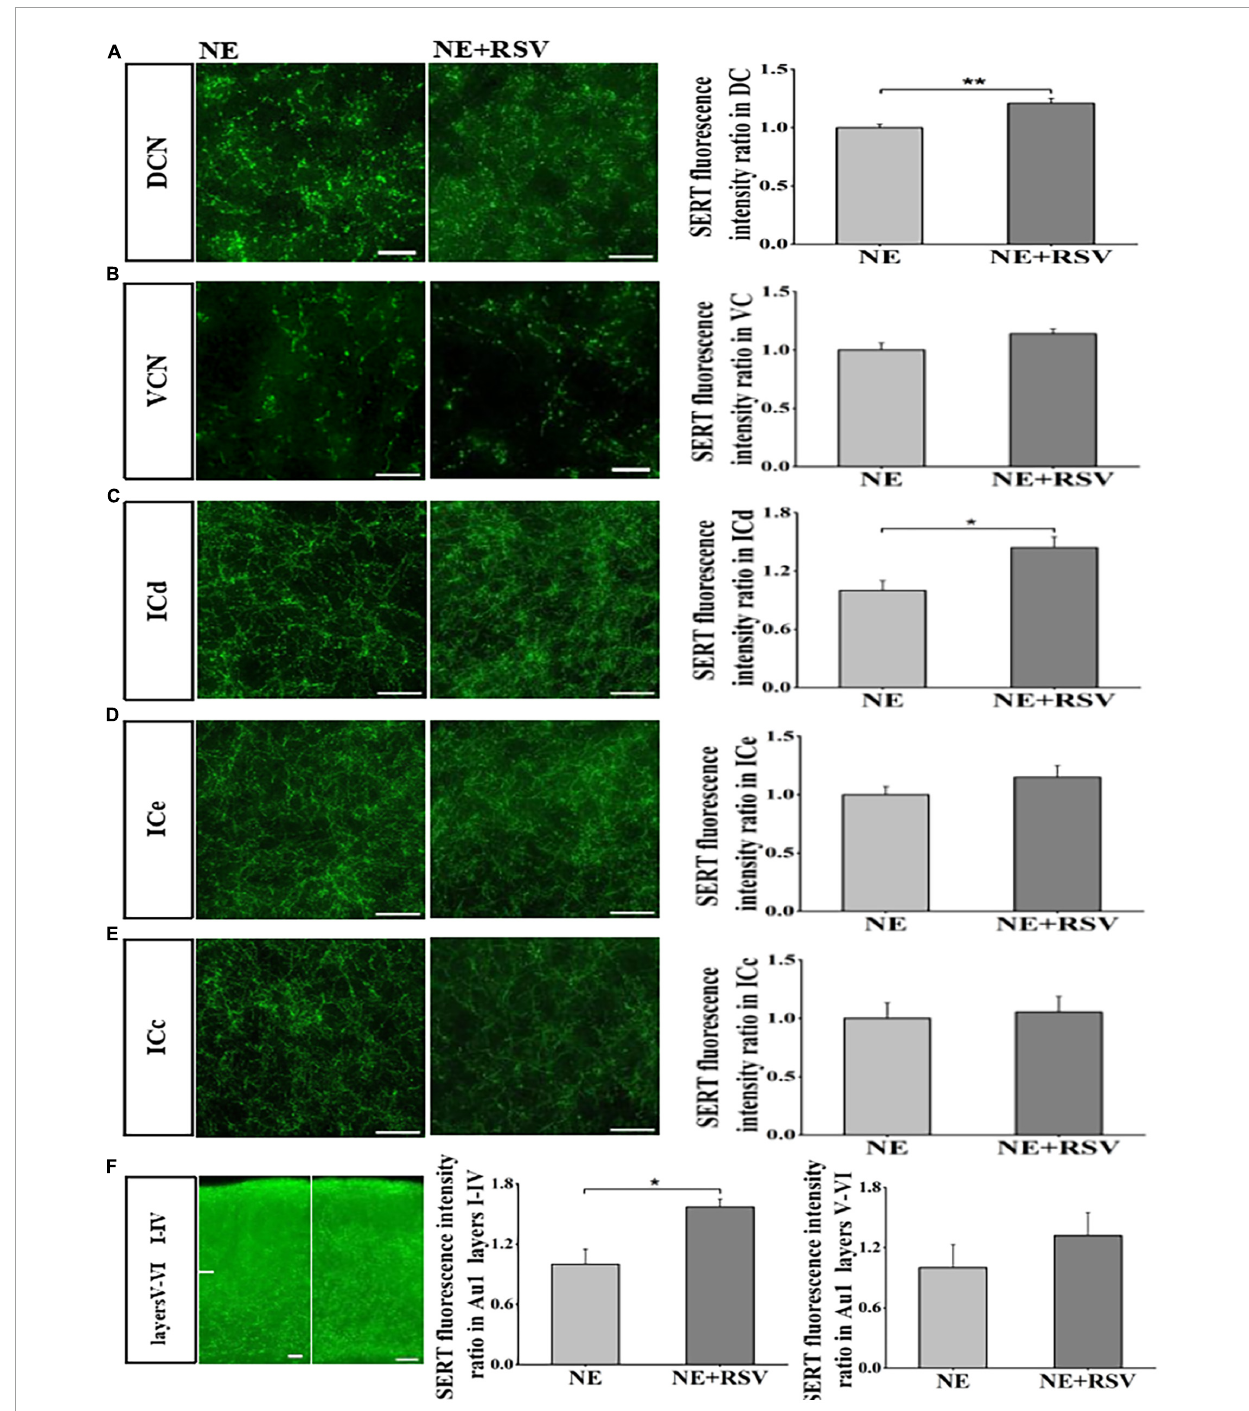
FIGURE5 Resveratrol protected against noise-induced SERT loss in auditory brain subregions. (A–F) Left: Micrograph taken with a 40 × magnification show the distribution of SERT + fibers in the DCN, VCN ICd, ICe, ICc, and Au1 layers I-VI. Right: Bar graphs represent the SERT immunofluorescence intensity ratio in these subregions between NE + RSV and NE groups. A quantitative immunofluorescence ratio was calculated by dividing SERT immunofluorescence intensity in NE + RSV group by that in the NE group. Values are mean ± SE, data was analyzed by Student’s t -tests. NE group n = 7; NE + RSV group n = 7. Statistical difference is represented as * p < 0.05, ** p < 0.01, and *** p < 0.001.